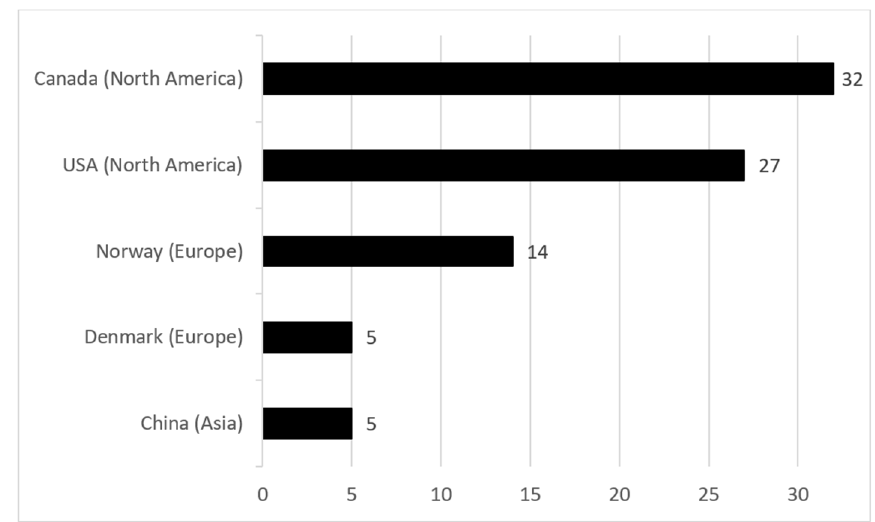
Figure 3. Top 5 most productive countries in oil spills research in ice ‐ infested waters.